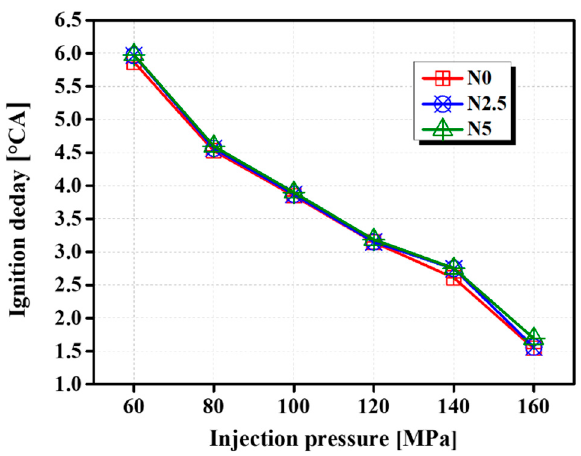
Figure 3. Variation of peaks ICP and HRR with respect to injection pressure for n -octanol/diesel blends.